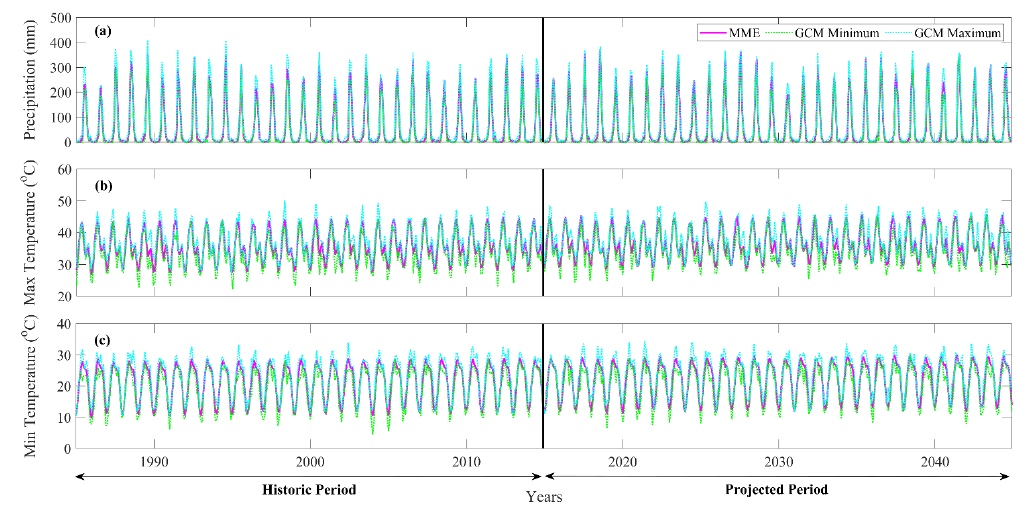
Figure 2. Time series of maximum and minimum values of global climate model (GCM) and the multi-model ensemble (MME) mean for the Araveli region (AV). ( a ) Precipitation; ( b ) maximum temperature; ( c ) minimum temperature.